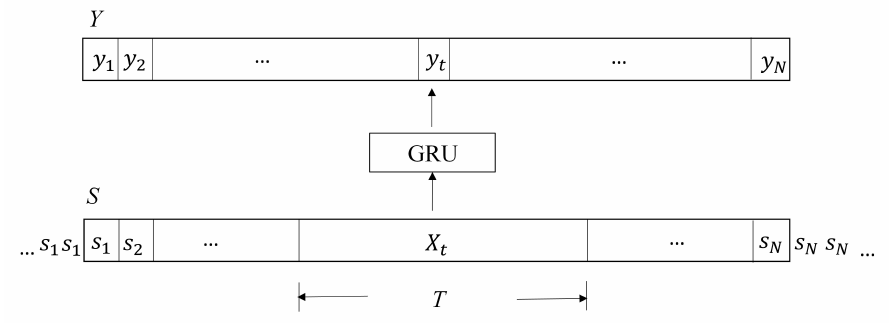
Figure 7. The gesture spotting operations based on the GRU. At the time step t , the X t is the input to the GRU, and y t is the result. The X t is a window of the sensory data S . It is centered at s t with length T